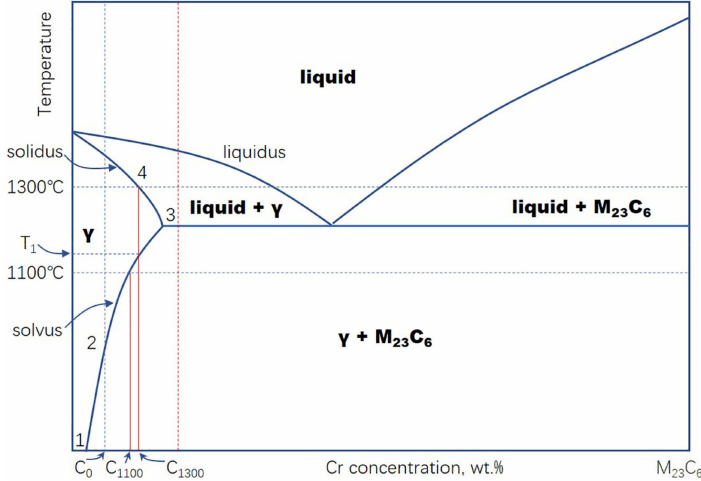
Figure 8. A schematic binary phase diagram between γ phase and M 23 C 6